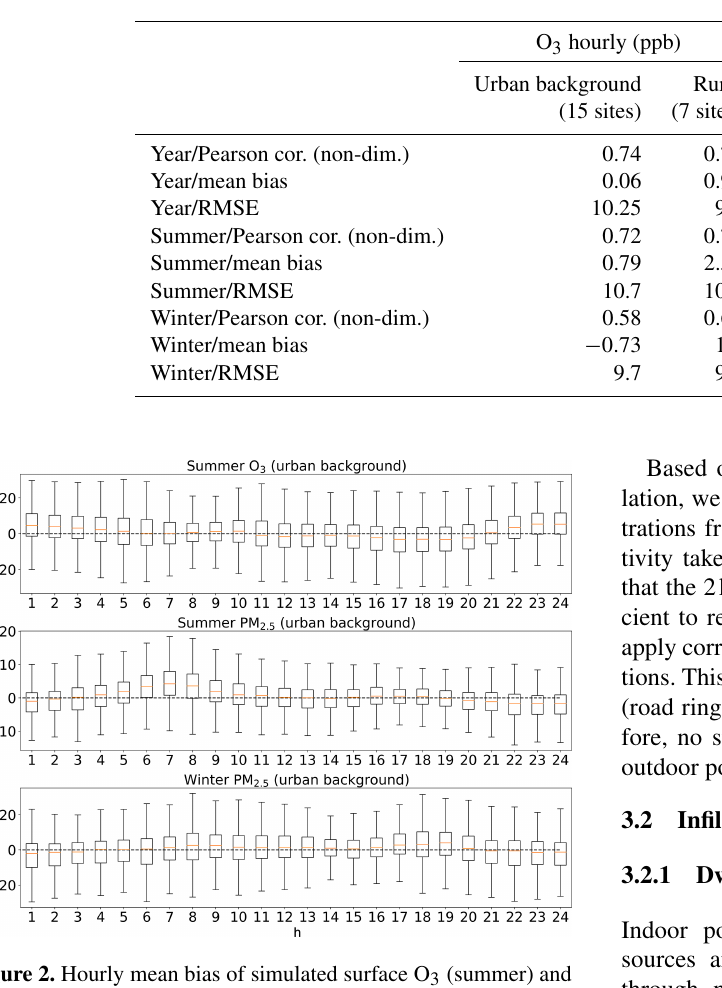
Table 1. Common metrics of statistical performance of the CHIMERE model, namely Pearson correlation, mean bias, and root mean square error, aggregated over the whole year of 2017, and for summer and winter seasons. Comparisons with traffic background and rural stations are conducted separately.